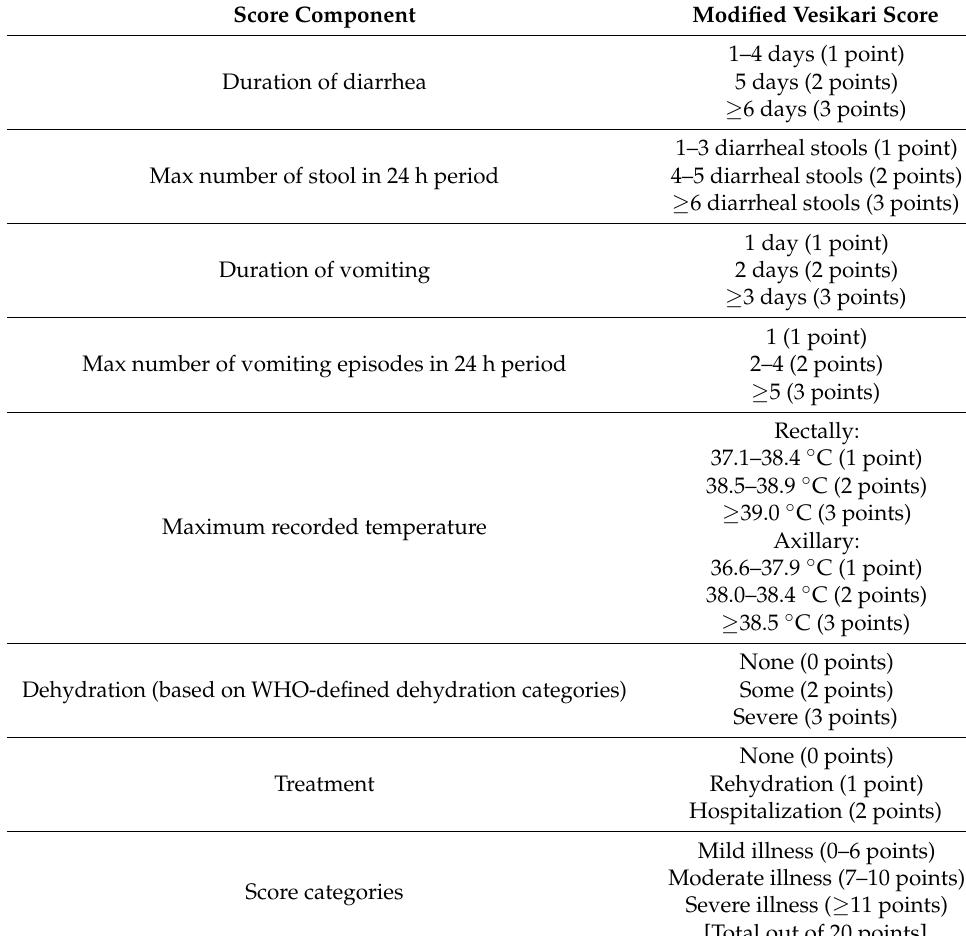
Table 2. Components of the modified Vesikari score used in the rotavirus vaccine